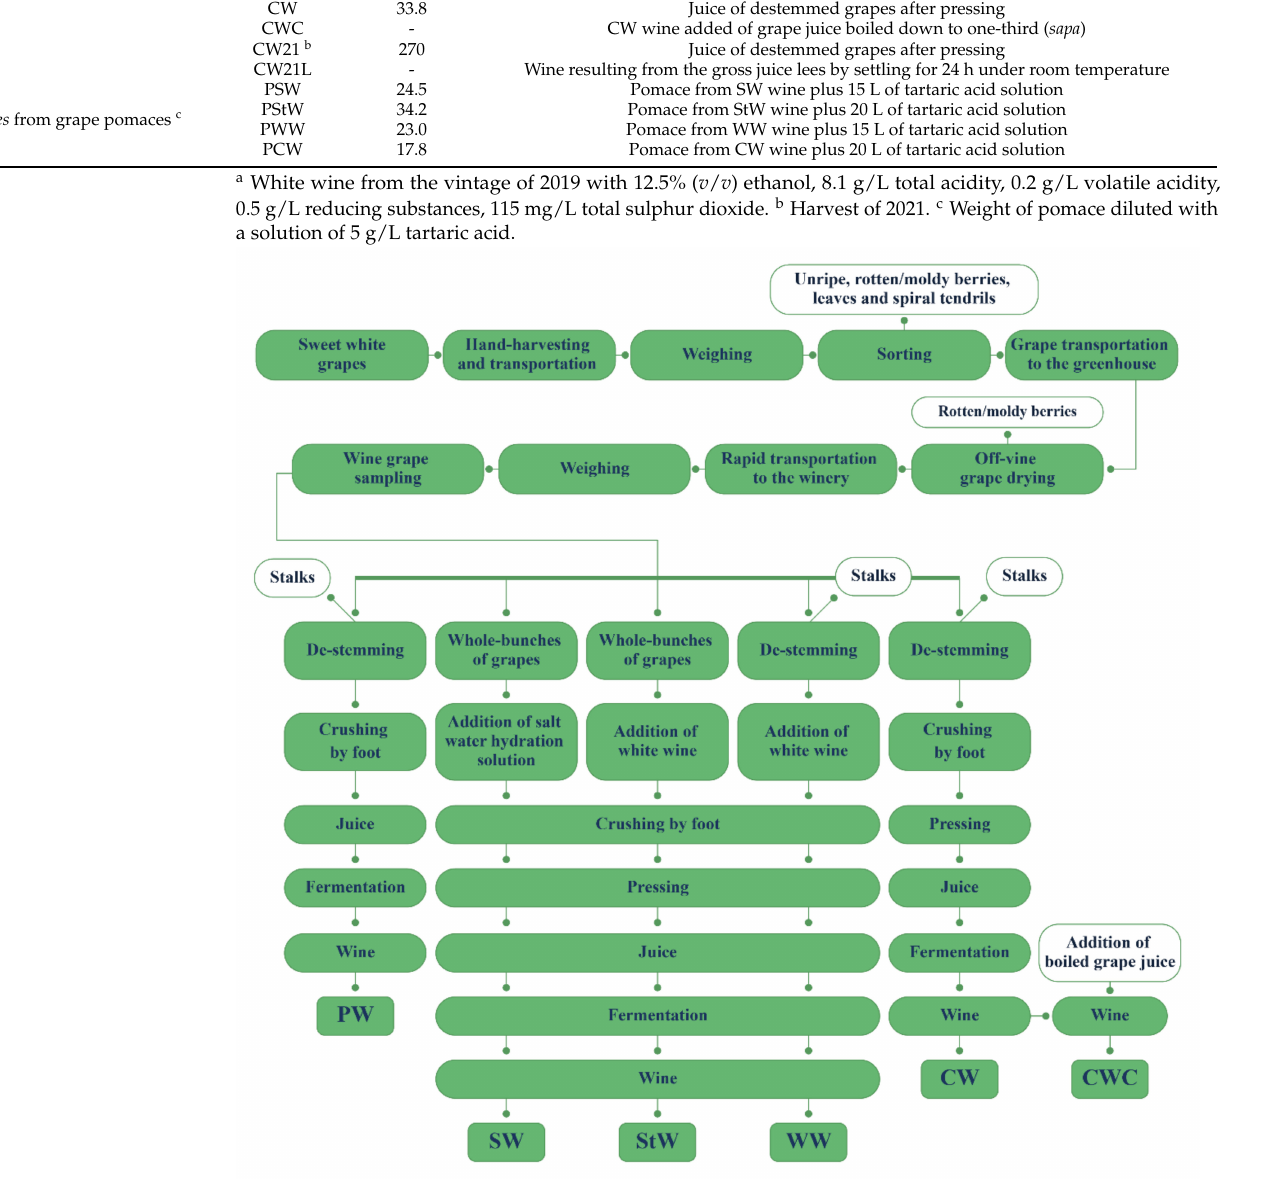
Figure 1. The simplified flow diagram of the withering and winemaking processes. During the 2021 harvest, the fermentation was carried out individually in two large open-top 100-L stainless-steel cylindrical tanks (Fratelli Marchisio & C. S.p.A., Imperia, Italy) at an average temperature of 24 ± 1 ◦ C. The juice was added to 80 mg/L potassium metabisulphite and 30 g/hL Fermol starter. The following steps were as described for the CW sample of the 2020